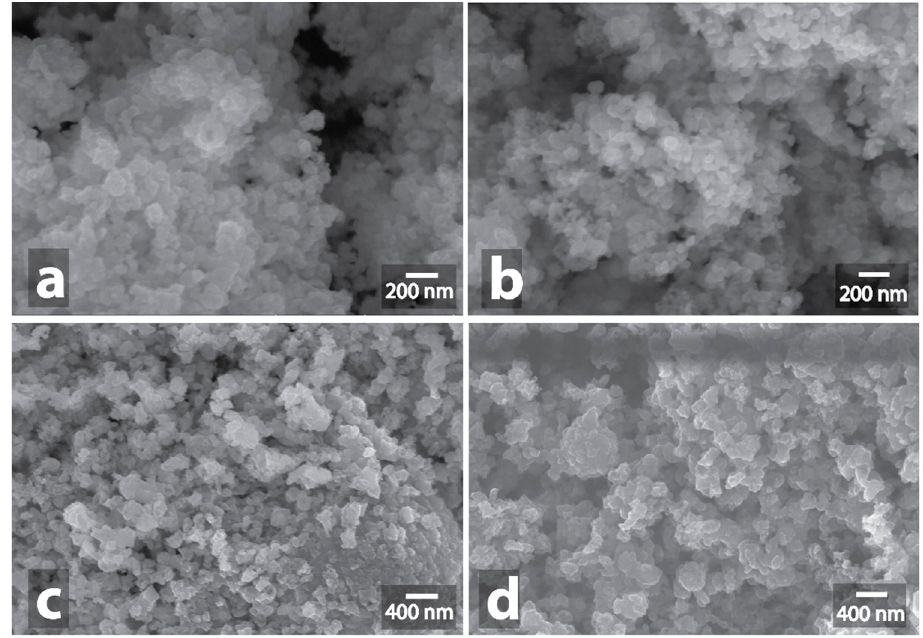
Figure 3. Scanning electron microscope (SEM) image of initial Cu powder ( a ) and SEM image of Cu powder after MW-treatment ( b ), initial Cu/C powder ( c ) and SEM image of Cu/C powder after MW-treatment ( d ).